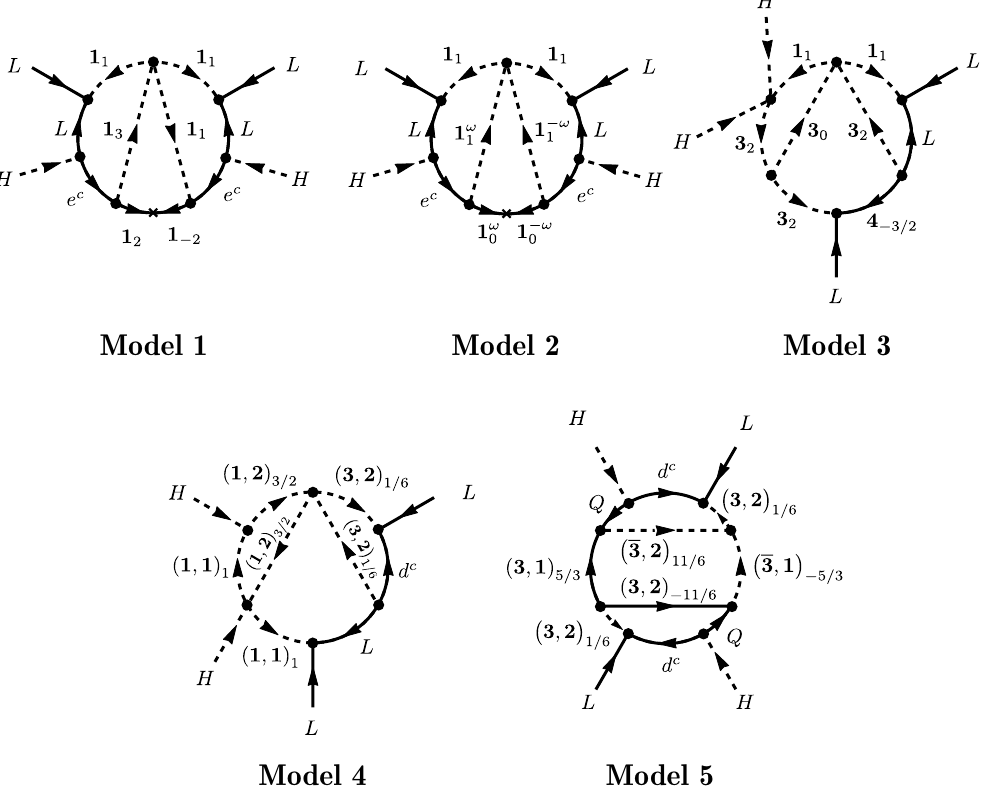
Figure 10 . Five examples of three-loop d = 5 genuine neutrino mass